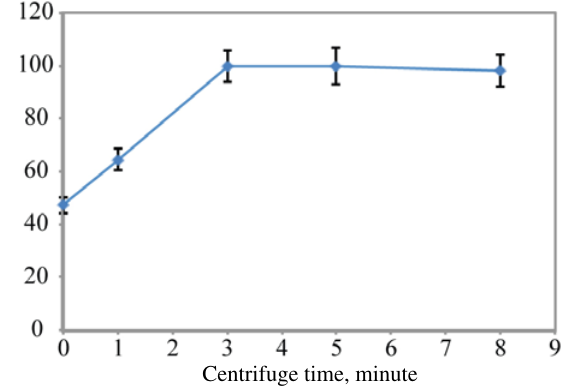
Figure 4. Influence of centrifuge time on recovery of 10 μg L –1 Au(III) ions as ion pair complex (sample volume: 8.0 mL,